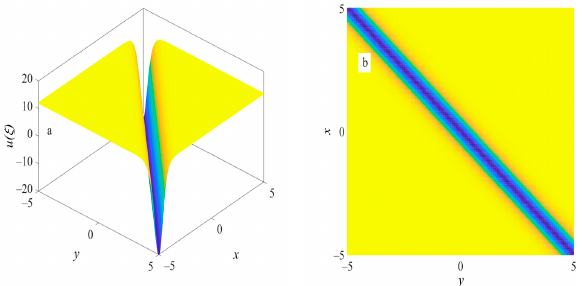
Figure 2. ( a ) Three-dimensional and ( b ) two-dimensional contour plots represent the dark solitary wave solution of Equation (35) when 𝑘 = 2,𝑙 = 1,𝑚 = 1, 𝜆 = 1,𝑡 = 1 and 𝜔 = 14 .